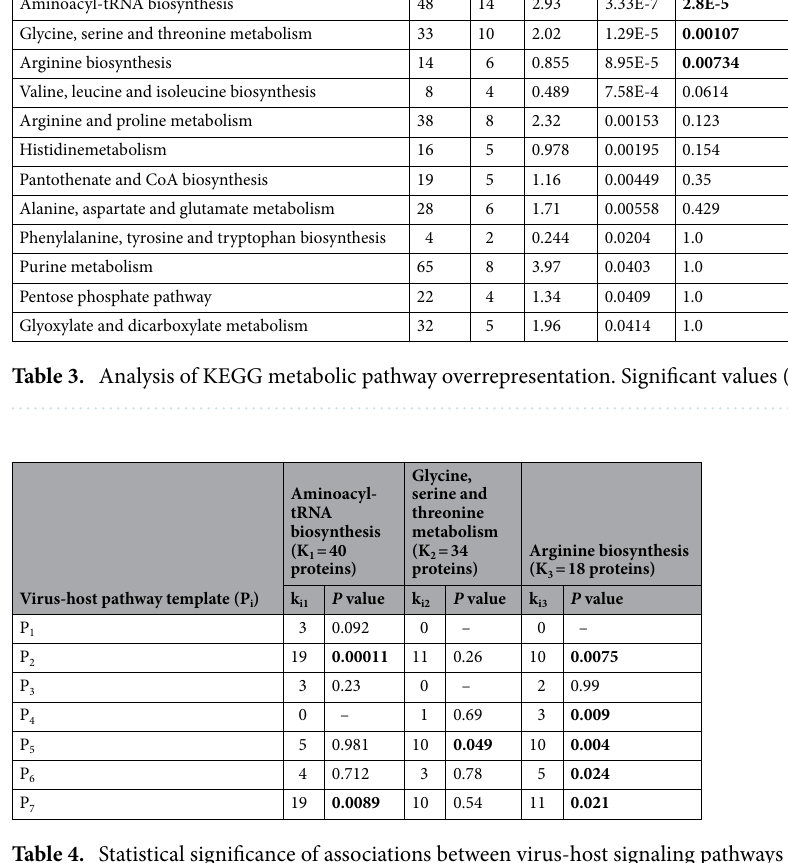
Table 4. Statistical significance of associations between virus-host signaling pathways and KEGG metabolic processes. Significant values ( p < 0.05) are in bold. K j is the number of proteins in KEGG metabolic pathway j, k ij is the number of proteins, which represent the targets of virus-host pathway template P i (Table 2).